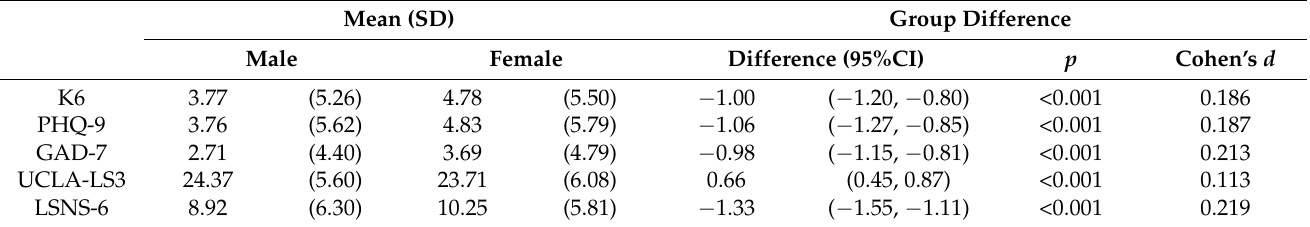
Table 3. Comparisons of psychological index scores between men and